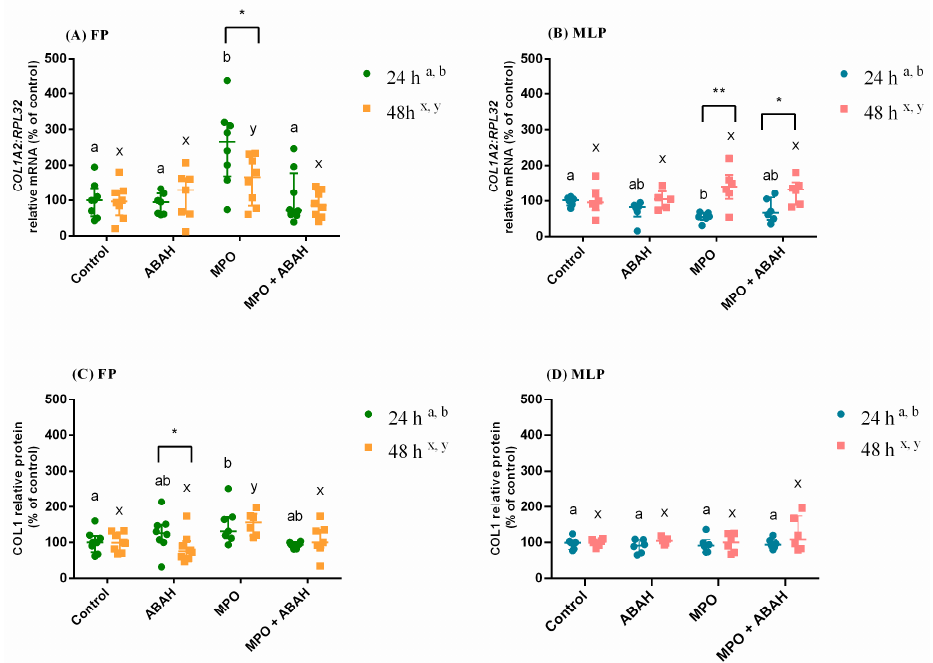
Figure 1. Relative mRNA transcription of type I collagen ( COL1A2 ) ( A , B ) and relative abundance of COL1 protein ( C , D ) in mare endometrial explants from the follicular phase (FP) and the mid-luteal phase (MLP) treated with culture medium only (Control), myeloperoxidase (MPO: 0.5 µg/mL), 4-aminobenzoic hydrazide (ABAH: 10 µg/mL), or MPO (0.5 µg/mL) + ABAH (10 µg/mL) for 24 or 48 h. Results are presented as median with interquartile range. Significance was determined at p < 0.05. The differences among treatments with the same treatment time are signaled by distinct superscript letters (a,b—24 h; x,y—48 h). The differences among times of treatment for the identical treatment are shown by asterisks (* p < 0.05; ** p < 0.01).